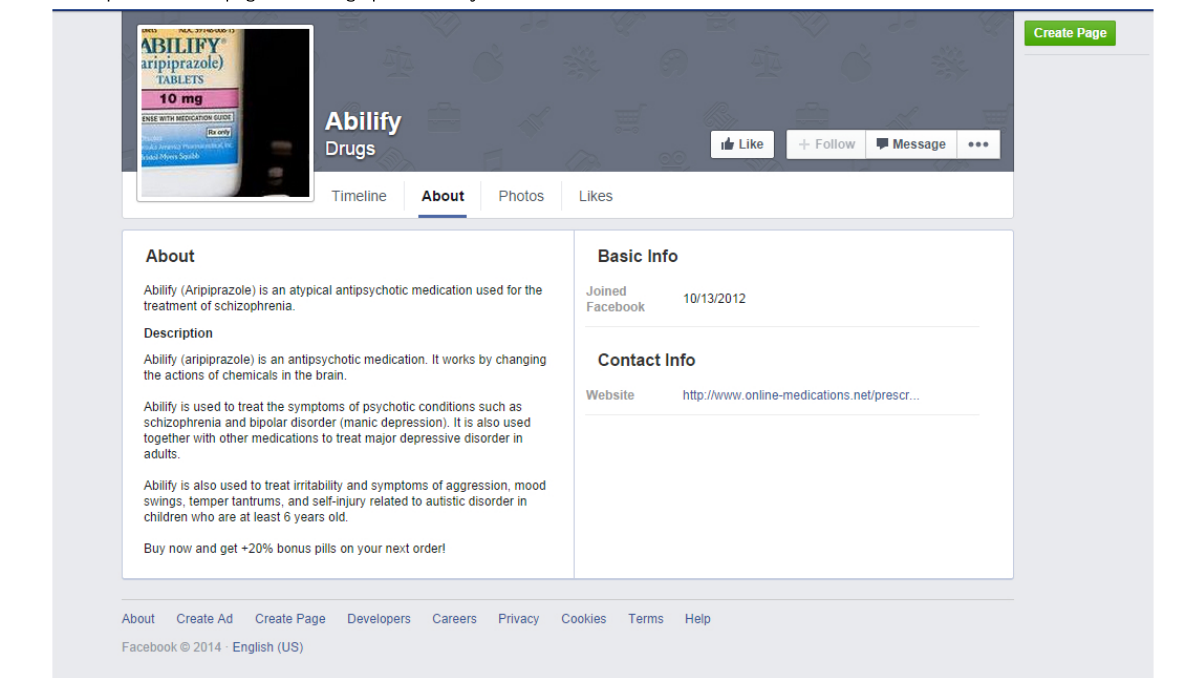
Figure 4. Example Facebook page from drug-specific